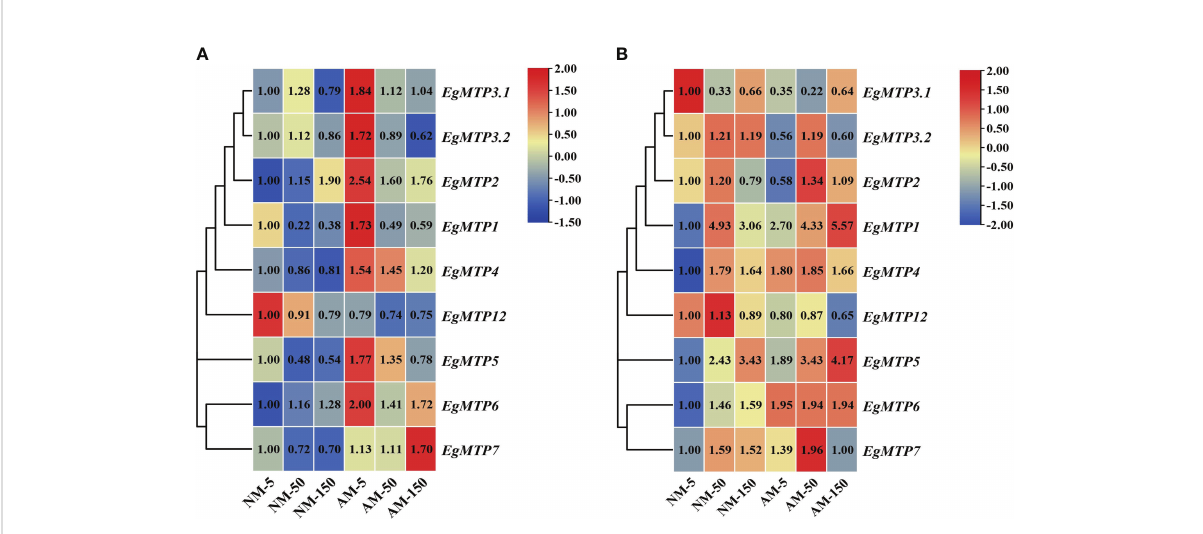
FIGURE 4 Expression pro fi les of EgMTP . The heat map was generated using the expression fold changes of EgMTP family. Relative gene expression was calculated by the 2 − DD CT method using the EgUBI3 as a normalizer. For each gene, the expression level in NM roots with 5 m M Zn was de fi ned as 1. (A) The expression pro fi les of EgMTPs in root. (B) The expression pro fi les of EgMTPs in